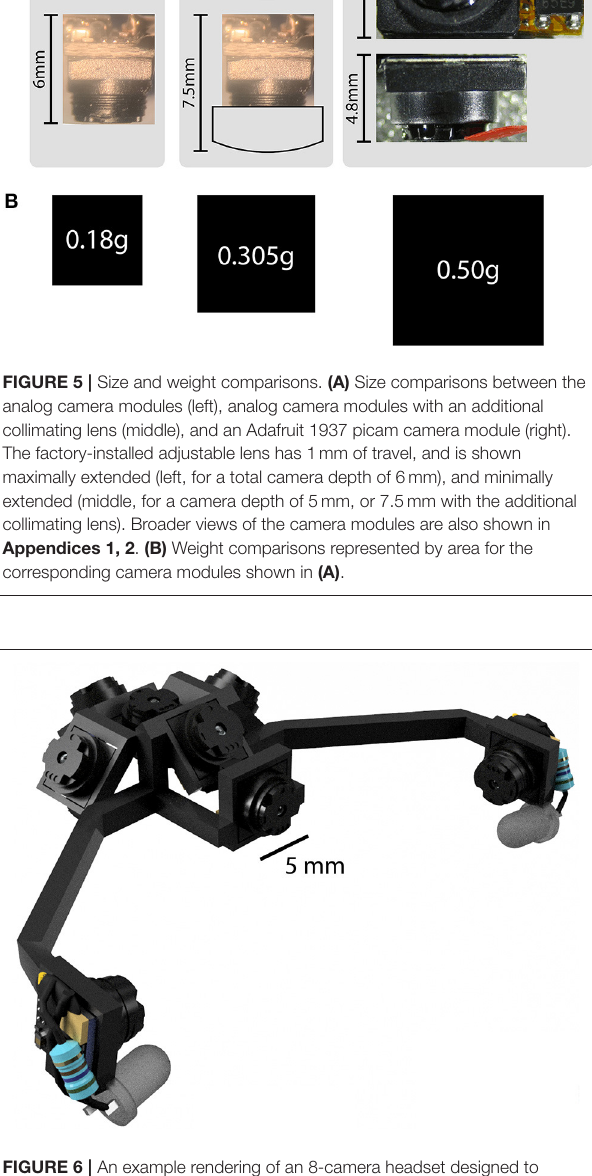
our system are significant, but the lower temporal resolution of the analog cameras (60 Hz compared to 90 Hz with the Adafruit 1937) presents a trade-off that depends on individual experimental